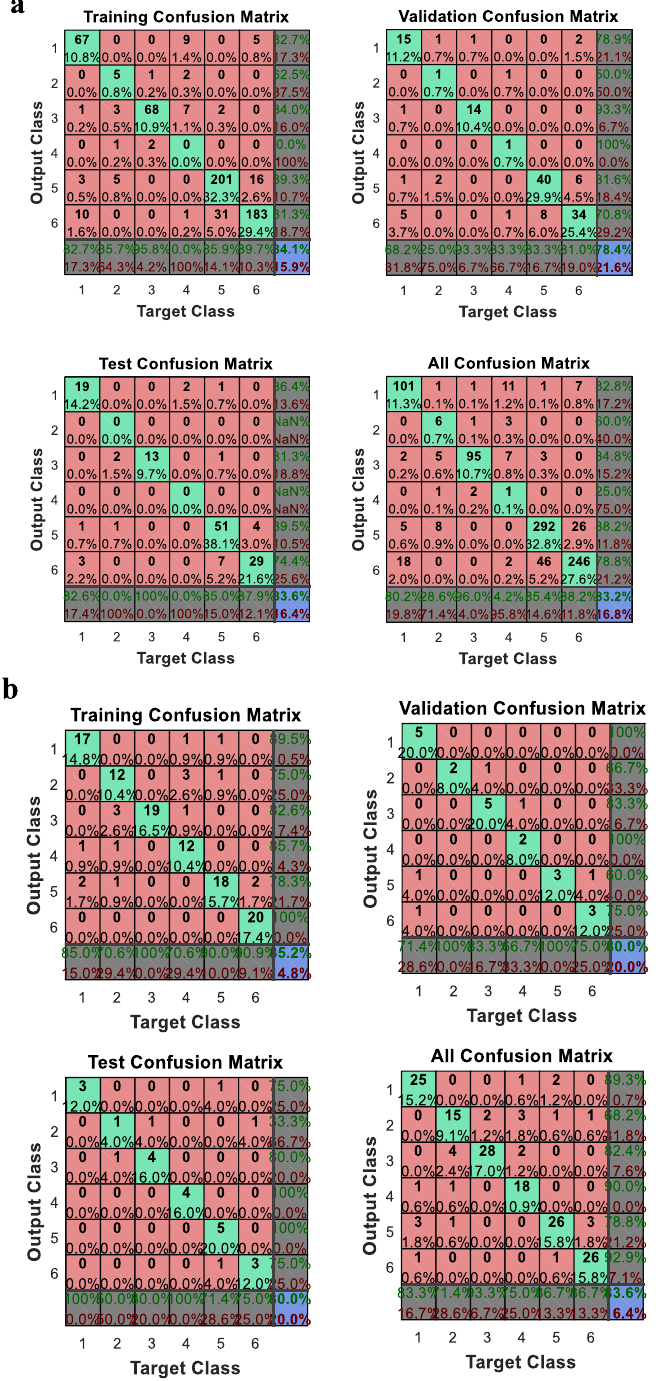
Figure 2. Confusion matrix to evaluate the prediction accuracy of 293 Maca samples ( a ) and 239 samples after weighted treatment ( b ) of six cities. The classes are: 1, Xichang; 2, Chuxiong; 3, Dali; 4, Kunming; 5, Lijing; and 6,